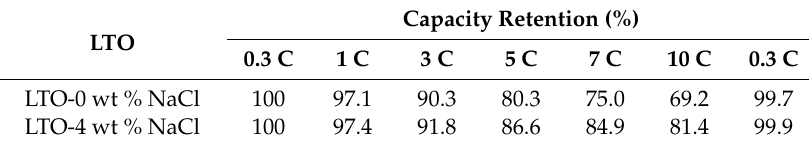
Figure 4. Rate ability of LTO-0 wt % NaCl and LTO-4 wt % NaCl. Table 2. Capacity retention of LTO / LiFePO 4 batteries at various